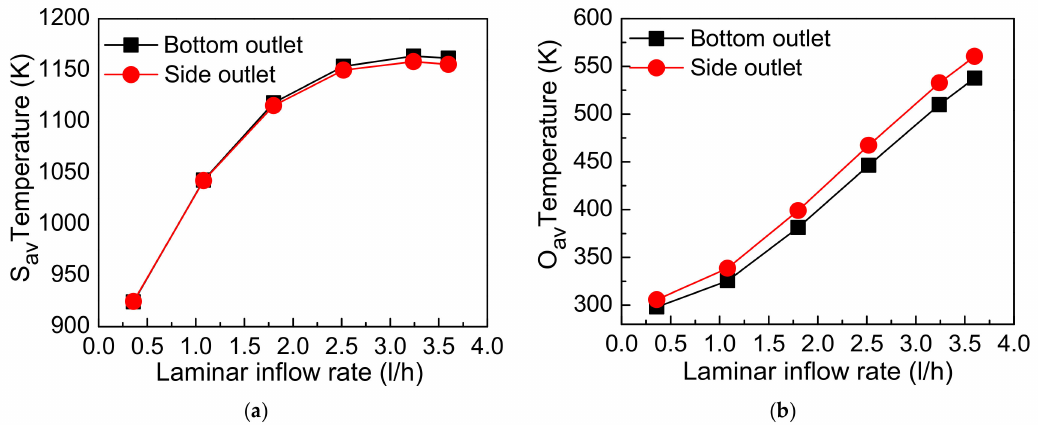
Figure 6. The average temperature for di ff erent laminar inflow rate at 150 kW / m 2 and 1 atm: ( a ) Surface average temperature and ( b ) Outlet average temperature.